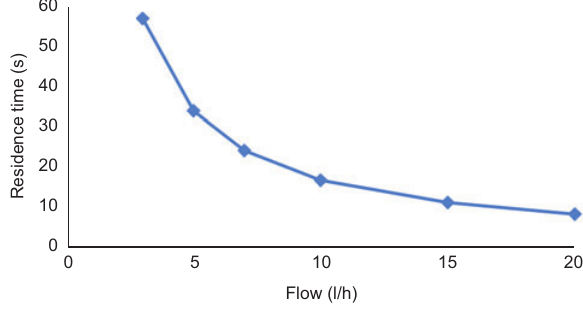
Figure 6 Dependence of residence time on fl ow rate.